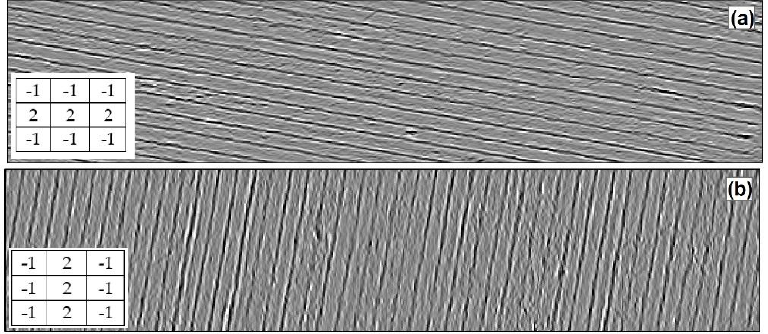
Figure 9. Line detection filters to detect lines in IDSM. ( a ) LDF-horizontal to detect east–west orientation; ( b ) LDF-vertical to identify the north–south orientation.